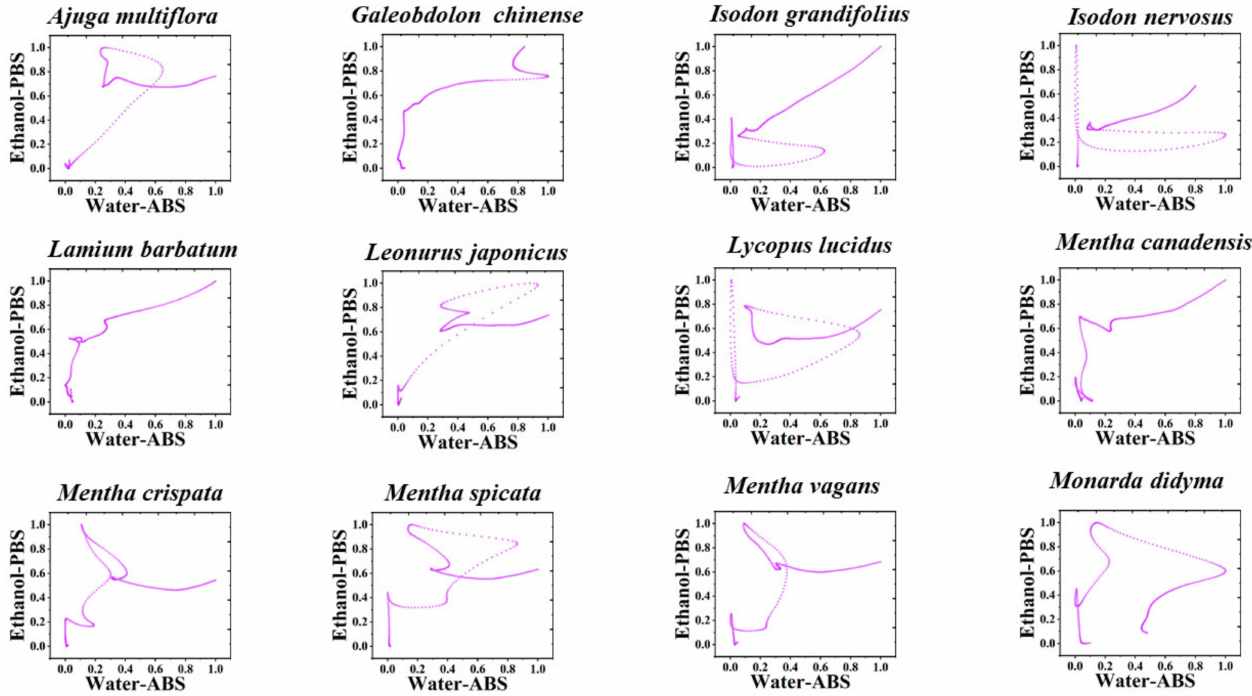
Figure 3. Scatter plots of 12 species of Lamiaceae combining the signals collected under PBS for the water extracts and under ABS for the ethanol extracts (the remaining 24 species can be found in the Supplementary